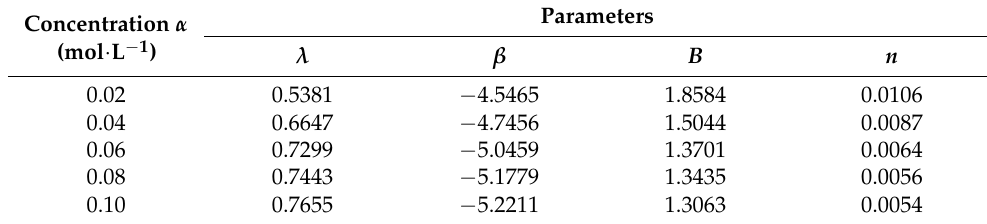
Figure 12. Data distribution curve of ( x , y ) of Na 2 SO 4 at different concentrations: ( a ) α = 0.02 mol · L − 1 ; ( b ) α = 0.06 mol · L − 1 ; ( c ) α = 0.10 mol · L − 1 . Table 5. Parameter calculation results ( σ 3 = 10 MPa).